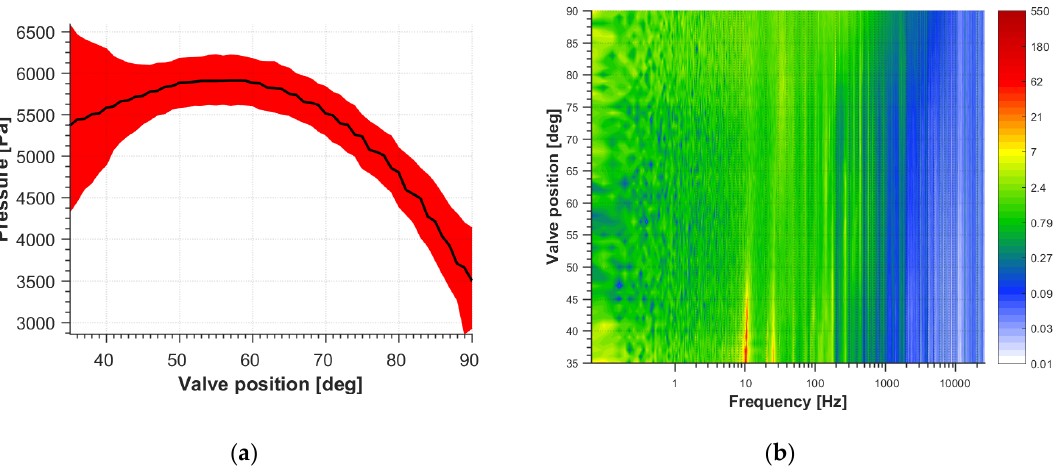
Figure 11. Pressure variation depending on the valve position measured at the outlet at impeller rotational speed 110 Hz. ( a ) The left plot represents the min-to-max plot (red) and the pressure average value (black). ( b ) The right plot represents the spectral map with the colormap in the logarithmic scale.